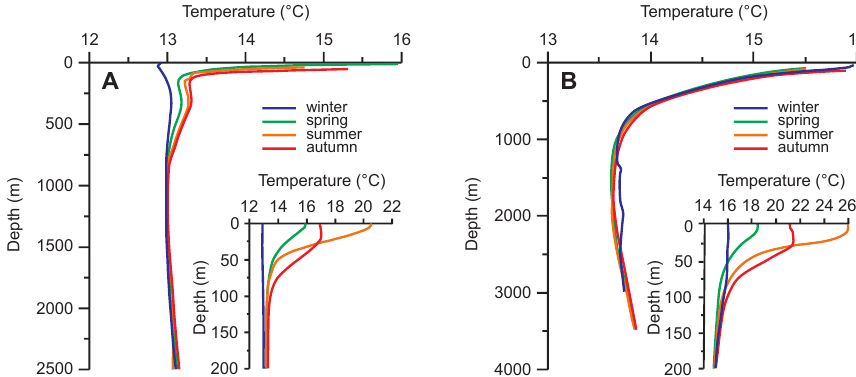
Figure 11. Seasonally averaged vertical profiles of water temperatures for ( A ) the Gulf of Lion in the western Mediter- ranean, and ( B ) the southern part of the Ionian Sea in the eastern Mediterranean (after Manca et al. [302], modified). The Mediterranean Sea is devoid of cold, bottom waters of Polar origin, and may be an analogy to ancient, epicontinental seas. 1.0